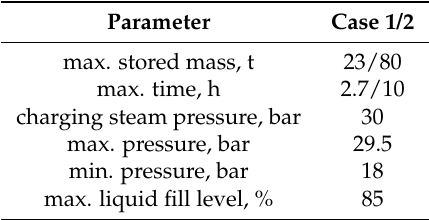
Table 4. Storage system requirements.